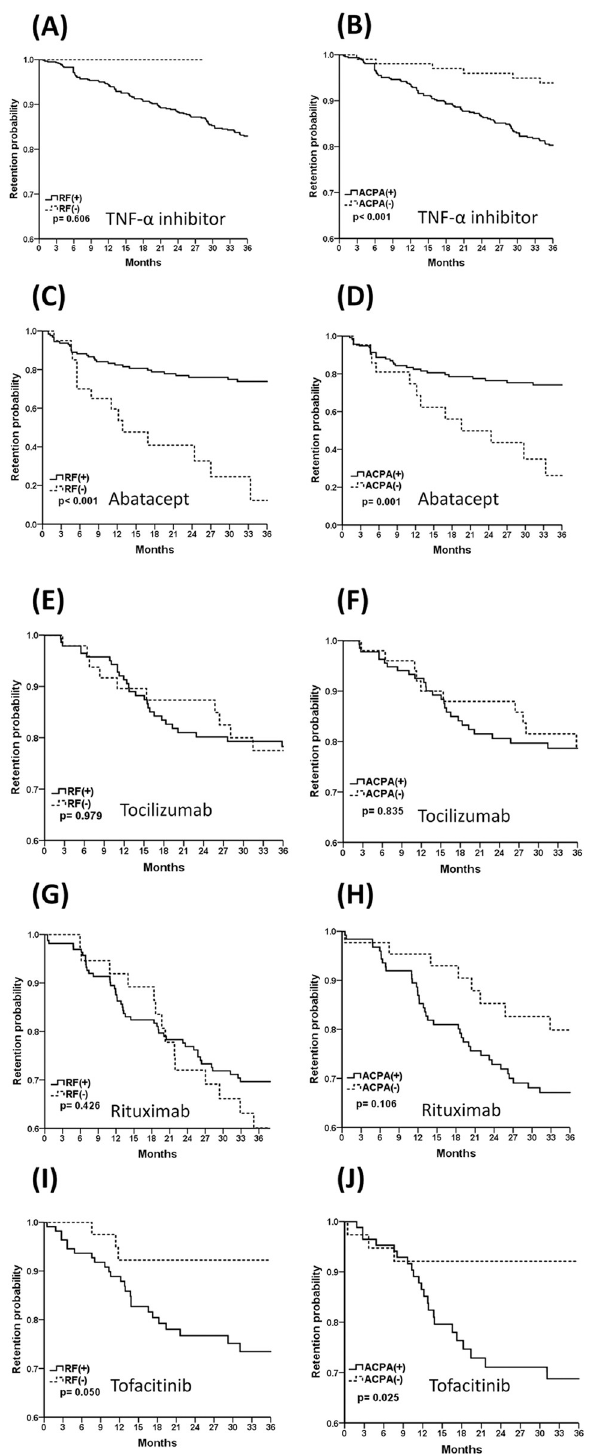
Fig 3. The 3-year Kaplan-Meier drug retention probability of TNF- α inhibitors (A, B), abatacept (C, D), tocilizumab (E,F), rituximab (G, H), and tofacitinib (I, J) by RF and ACPA positivity. TNF- α , tumor necrosis factor-alpha; RF, rheumatoid factor; ACPA, anti-citrullinated protein antibody.